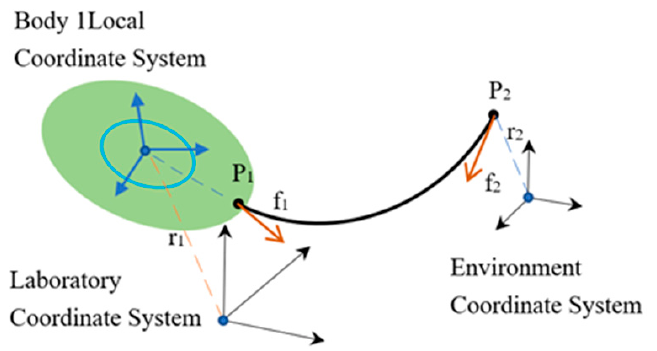
Figure 1. The catenary coupling element.